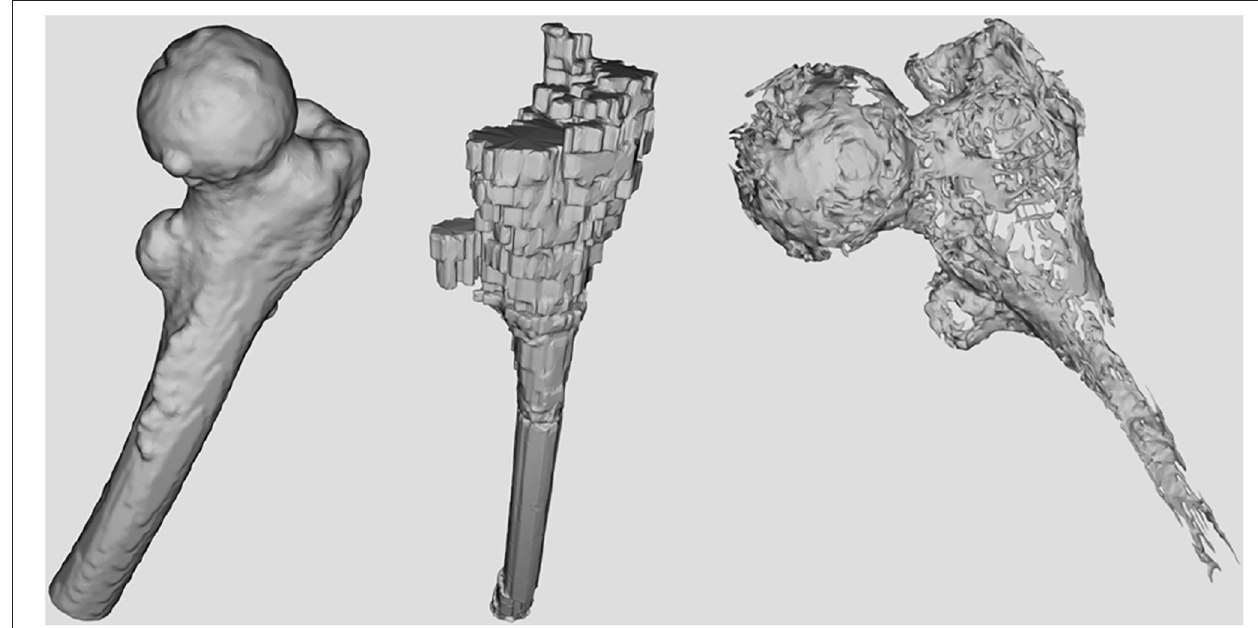
FIGURE 4 | The surfaces corresponding to the bone’s layers extracted from CT data. From left to right: Cortical bone surface, bone marrow, and